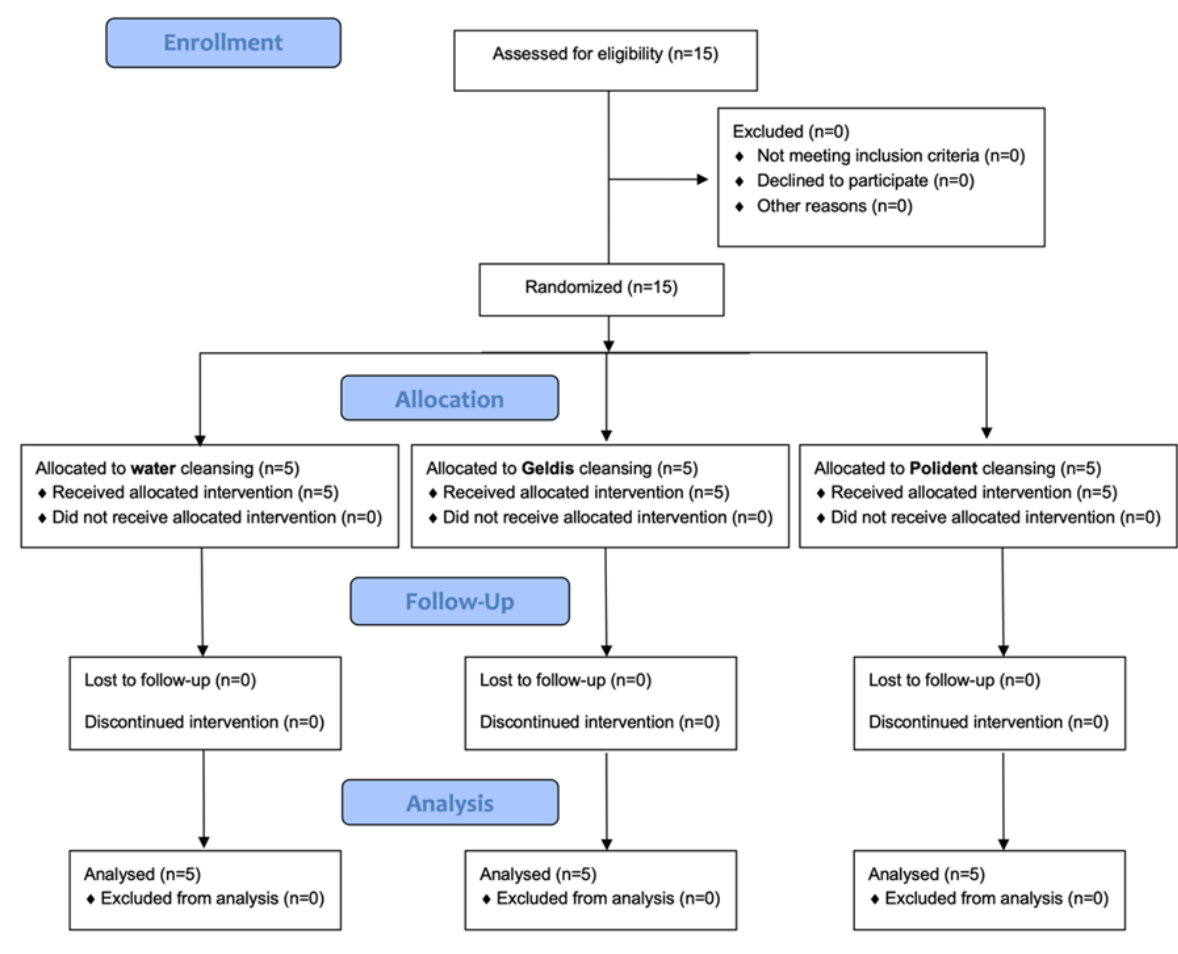
Figure 1. CONSORT flow chart of the study.